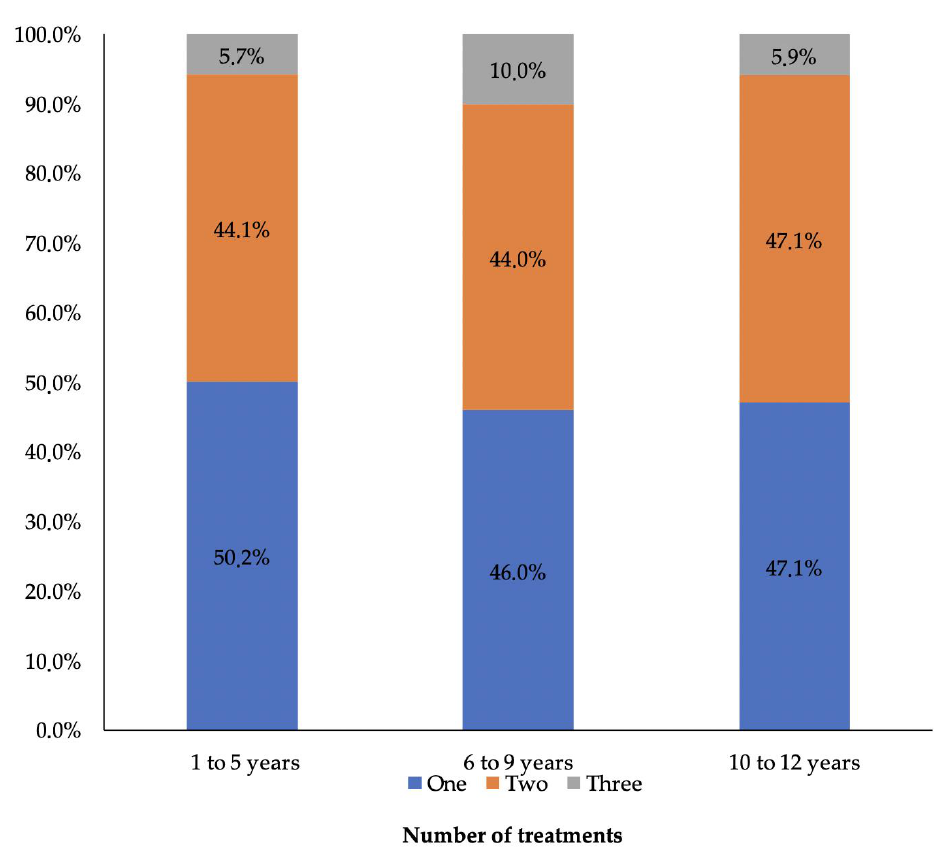
Figure 2. Number of dental treatments according to age group by sedation appointments. Note: In